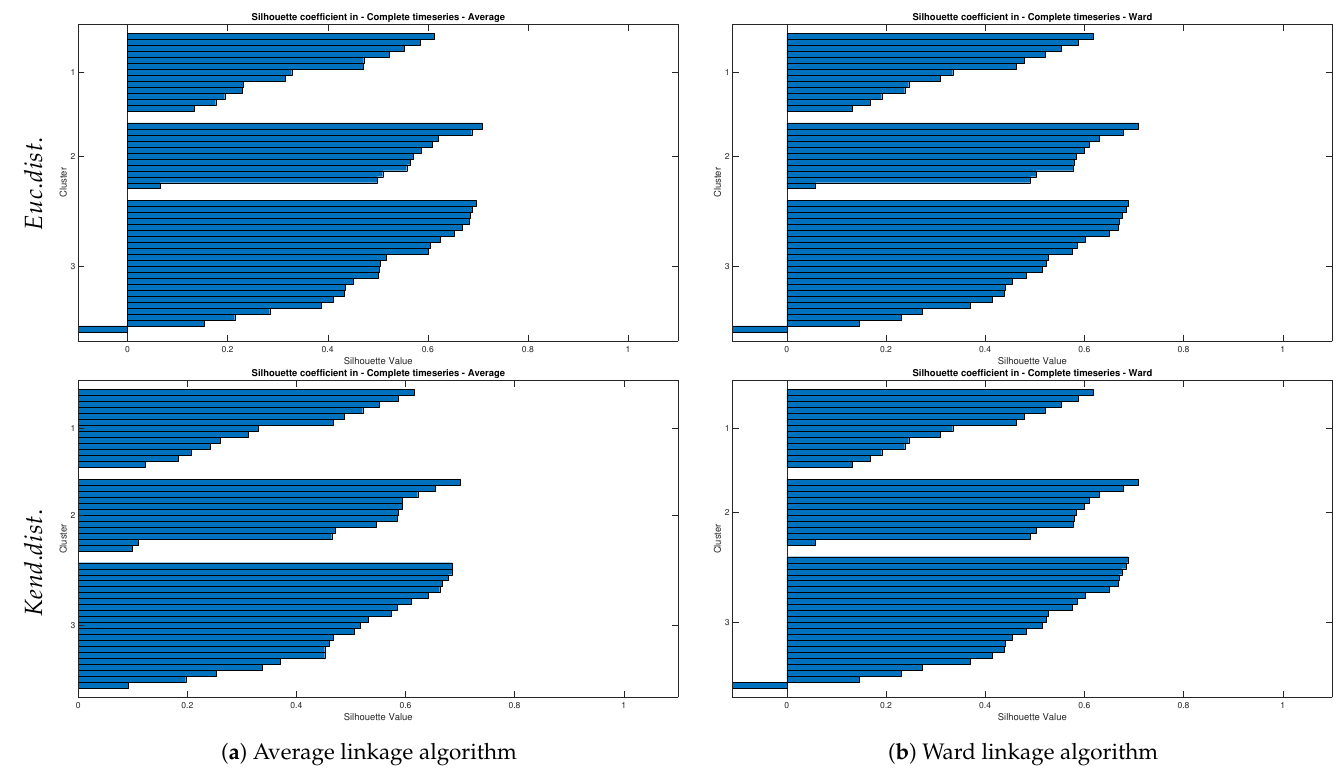
Figure 11. Silhouette coefficient of different hierarchical